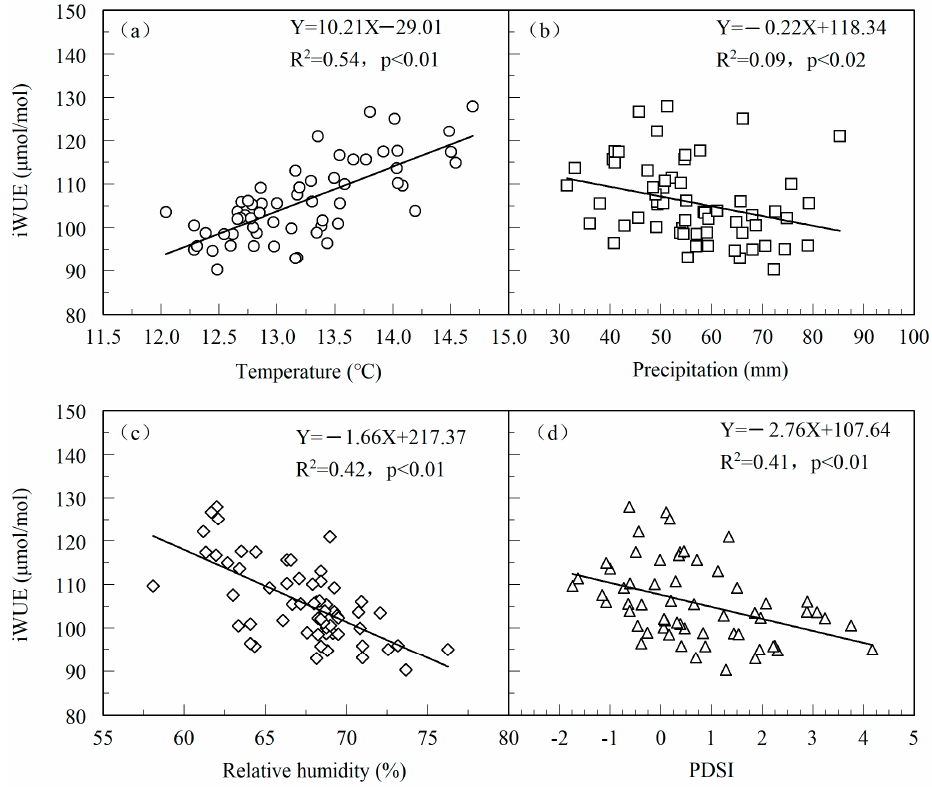
Figure 7. Scatter diagrams of the relationship between iWUE and annual mean temperature ( a ), annual mean precipitation ( b ), annual mean relative humidity ( c ), and annual mean PDSI ( d ). The straight line represents the change trends. The regression equation, explained variance, and level of significance are also shown.